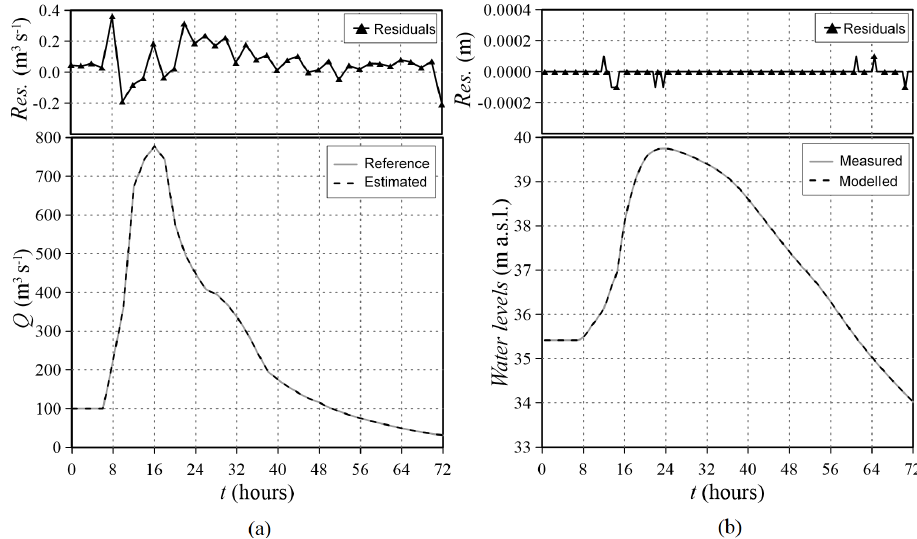
Figure 13. Secchia River: reference and estimated inflow hydrograph (a) and observed (uncorrupted) and modelled water levels (b) . The residuals between reference and estimated values are also reported.